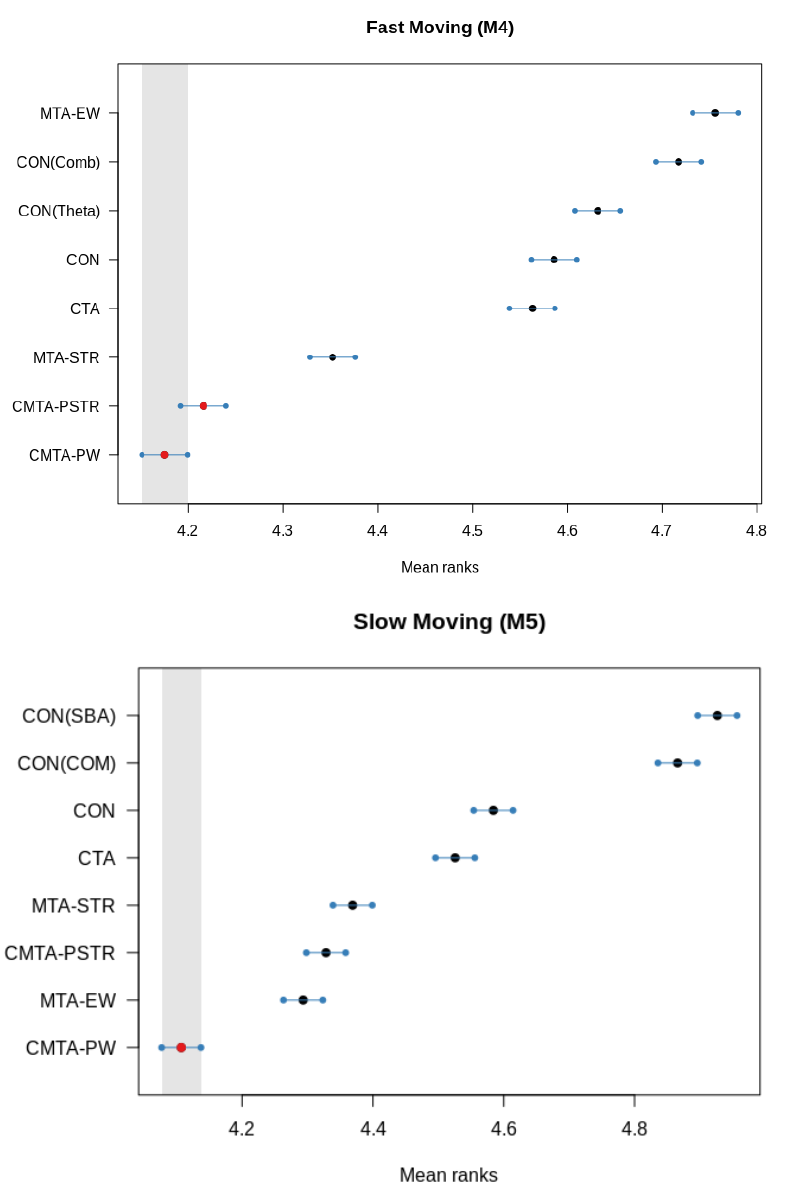
Figure 4. MCB test of the methods utilized within the study for forecasting the series of the M4 ( top ) and M5 ( bottom )